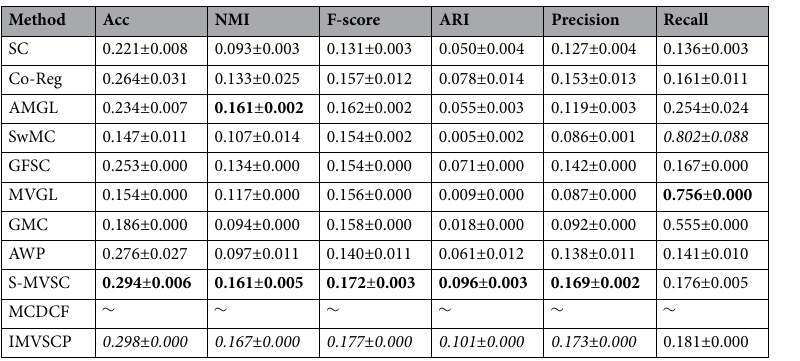
Table 5. Experimental results (mean standard deviation) on the Mfeat dataset. Significant values are in [bold/ italics]. ‘ ∼ ’ indicates that the running time of the algorithm exceeds one hour, and the following is the same